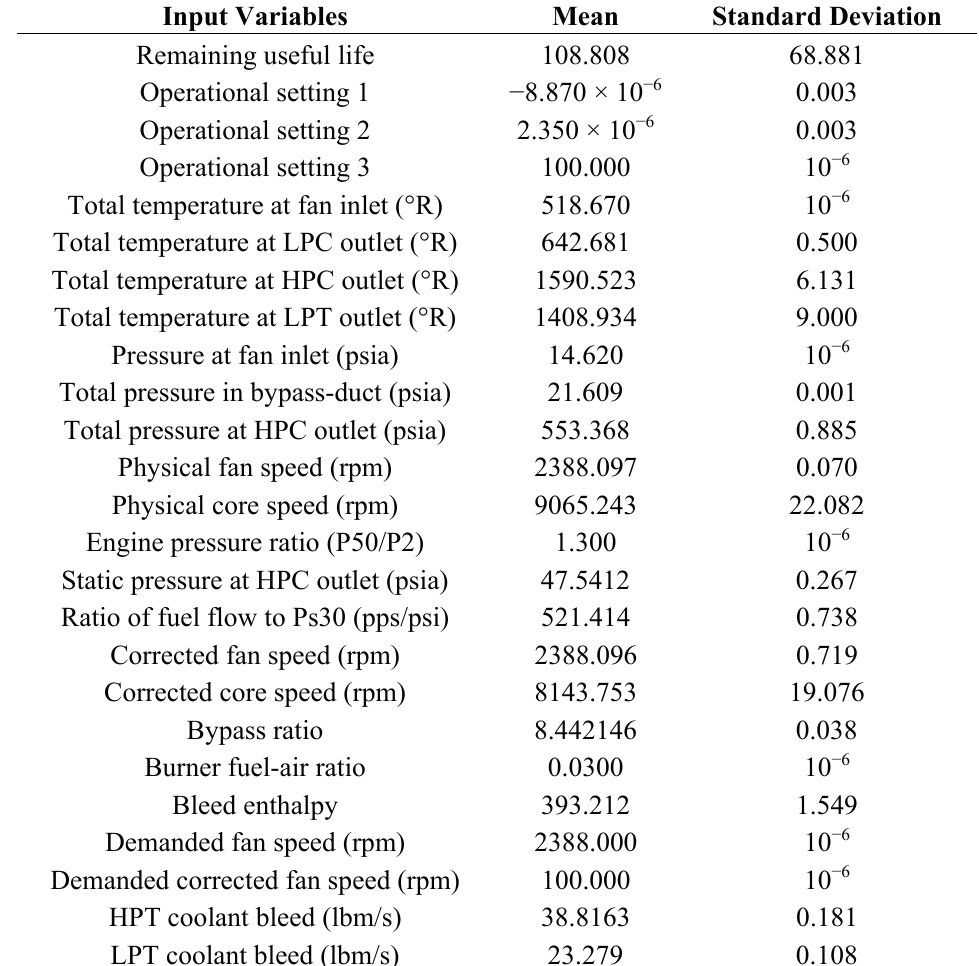
Table 2. Descriptive statistics of all the variables of the